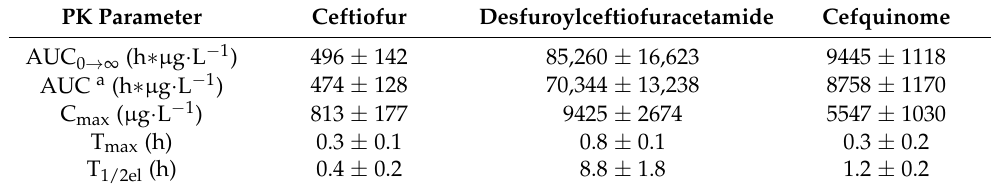
Figure 1. ( A ) Mean plasma concentrations ( ± standard deviation; n = 8) of ceftiofur after the first administration (0–4 h) and for the timepoints right before and at the time of maximum concen- tration (T max ) of every repeated administration during the entire treatment period (0–49 h) with intramuscular administration of 3 mg · kg − 1 body weight. The bolus was administered once daily for 3 consecutive days. ( B ) Mean plasma concentrations ( ± standard deviation; n = 8) of ceftiofur and ceftiofur-related residues, measured as desfuroylceftiofuracetamide, after the first administration of ceftiofur (0–11 h) and for the timepoints right before and at the T max of every repeated administration during the entire treatment period (0–49 h). ( C ) Mean plasma concentrations ( ± standard deviation; n = 8) of cefquinome after the first administration (0–6 h) and for the timepoints right before and at the T max of every repeated administration during the entire treatment period (0–96.5 h) with intramuscular administration of 2 mg · kg − 1 body weight. The bolus was administered once daily for 5 consecutive days. Table 1. Overview of mean plasma pharmacokinetic (PK) parameters ( ± standard deviation): area under the curve from 0 to ∞ (AUC 0 → ∞ ) for al analytes, from 0 to 2 h (AUC 0 → 2 h ) for ceftiofur, from 0 to 24 h (AUC 0 → 24 h ) for desfuroylceftiofuracetamide and from 0 to 4 h (AUC 0 → 4 h ) for cefquinome, and calculated maximal plasma concentration (C max ), time of C max (T max ) after the first administration, elimination half-life (T 1/2el ) within these time frames. PK